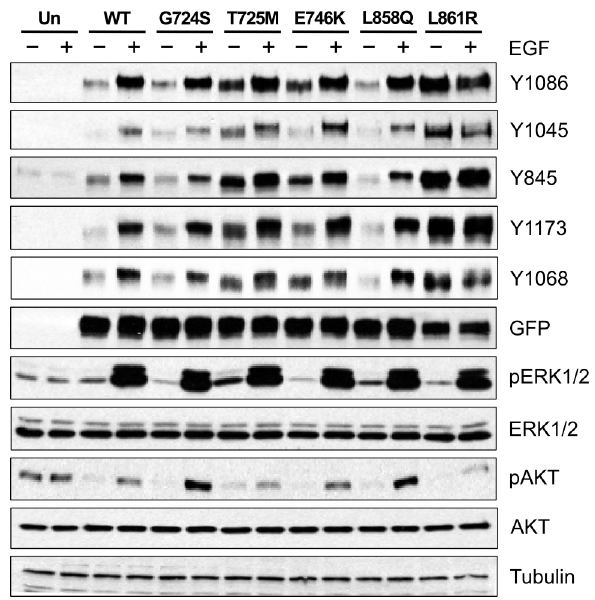
Figure 2. Auto-phosphorylation of wild-type and mutant EGFR and impact of mutations on downstream EGFR signaling. The blot shows phosphorylation of the four C-terminal tail tyrosines (Y1086, Y1045, Y845, Y1173 and Y1068) in EGFR, and two downstream proteins, ERK1/2 and AKT, in the presence ( + ) and absence( 2 ) of EGF. ‘‘Un’’ indicates untransfected CHO cells. Total levels of EGFR (GFP), ERK1/2, AKT and tubulin (control) are also shown.